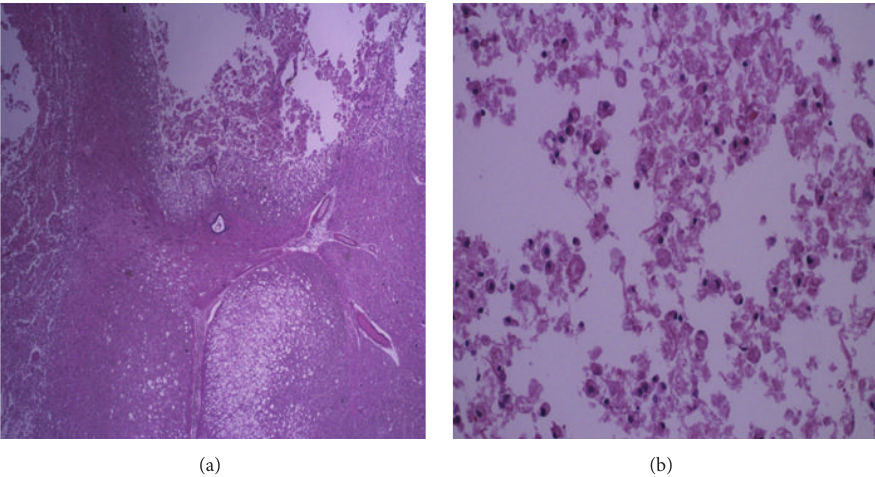
Figure 4: Low power of the central cervical cord (note central canal) showing cystic areas of acute infarct; 2xb is a low power of the lateral cervical cord with similar changes; high power showing a cystic area with debris and macrophages.